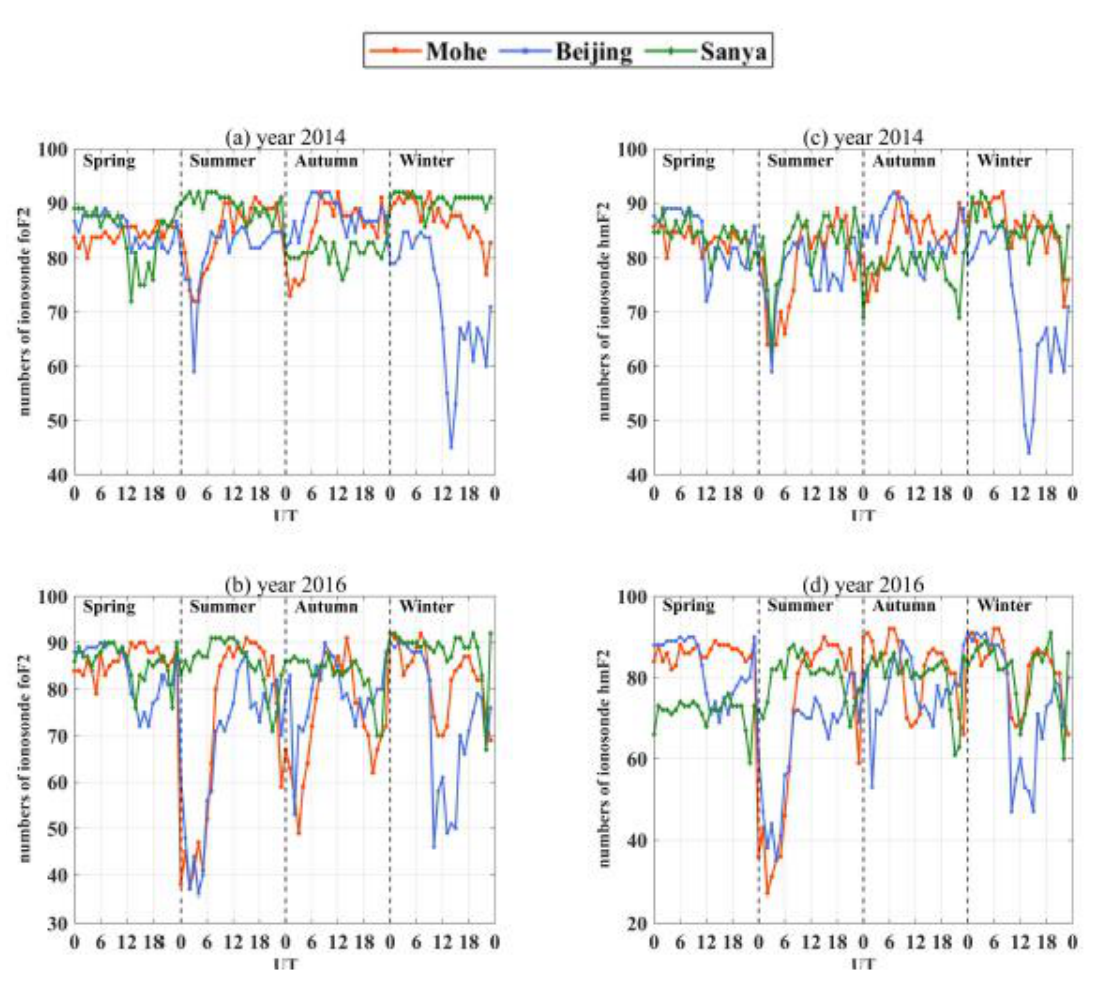
Figure 3. Diurnal number of measurements of foF2 and hmF2 ionosonde parameters in the four different seasons for the years 2014 and 2016 at Mohe, Beijing and Sanya. ( a ) diurnal number of foF2 in 2014, ( b ) diurnal number of foF2 in 2016, ( c ) diurnal number of hmF2 in 2014, ( d ) diurnal number of hmF2 in 2016.